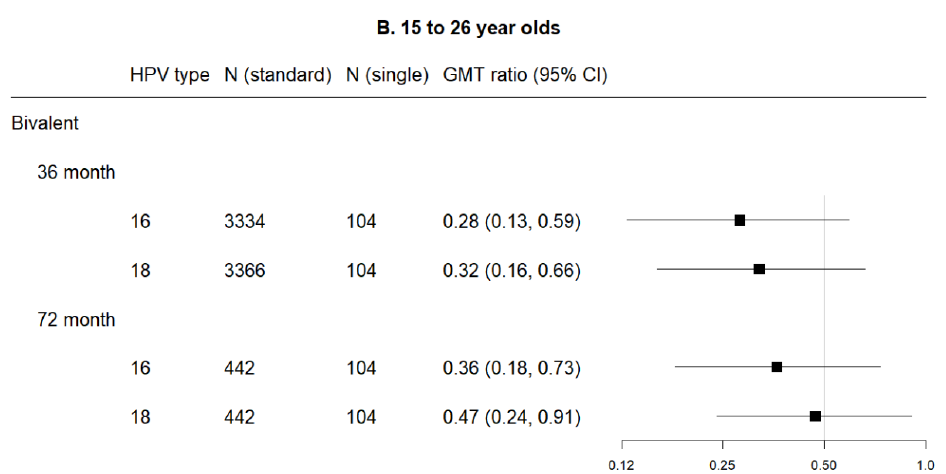
Figure 5. Forest plot of GMT ratio of single dose versus standard schedule (with 0.5 indicating the non-inferiority cut-point—i.e., those with lower bounds greater than 0.5 are considered to meet non-inferiority criteria), by vaccine, HPV subtype, and time point among ( A ) 9 to 14 year olds and ( B ) 15 to 26 year olds.